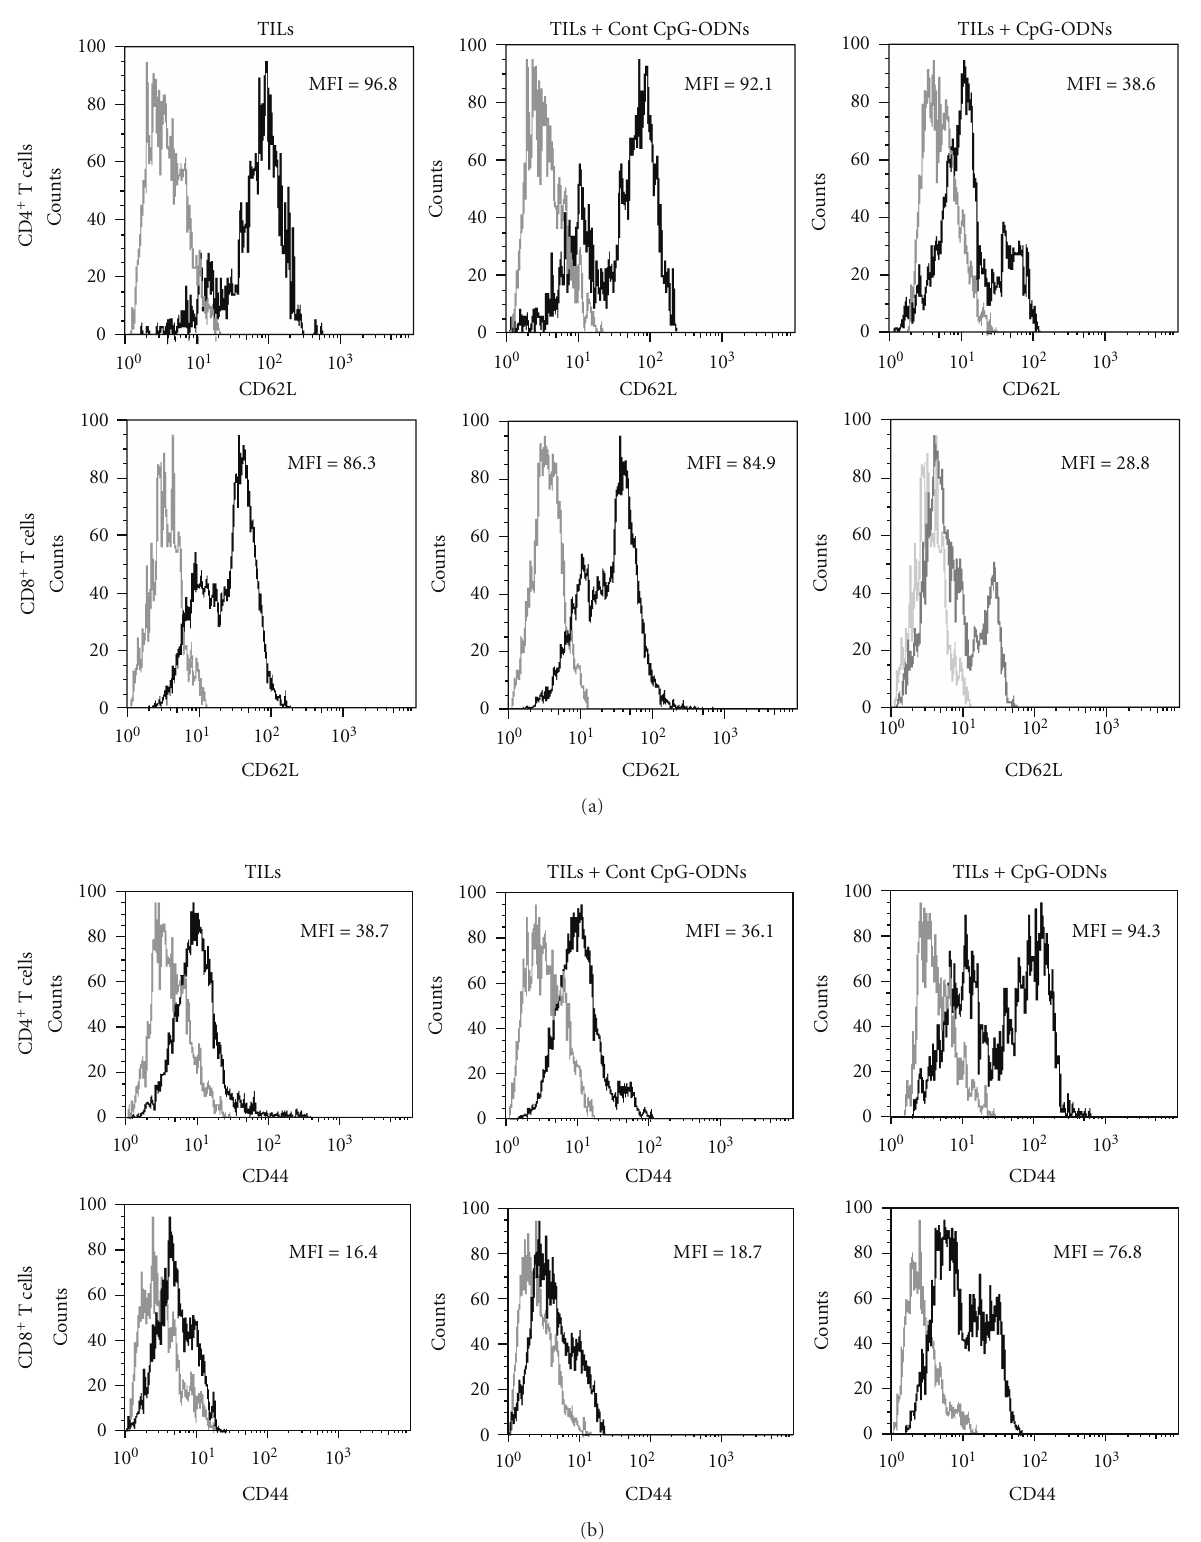
Figure 2: CpG-ODNs altered the expression of CD62L and CD44 on CD4 + T cells and CD8 + T cells. TILs were collected from lung cancer patients ( n = 16) and treated with CpG-ODNs or control CpG-ODNs as described in Materials and Methods . 1 × 10 7 autologous TILs were transferred into the tumor bearing Balb/c nude mice with 100 ug CpG-ODNs or control CpG-ODNs through tail vein. Ten days later, the lymphocytes were isolated from tumor mass and the expression of CD62L (a) and CD44 (b) on CD4 + T cells and CD8 + T cells was analyzed by FACS. Representative data referring to the mean of data obtained from all the patients included in each group was shown. ∗ P < .